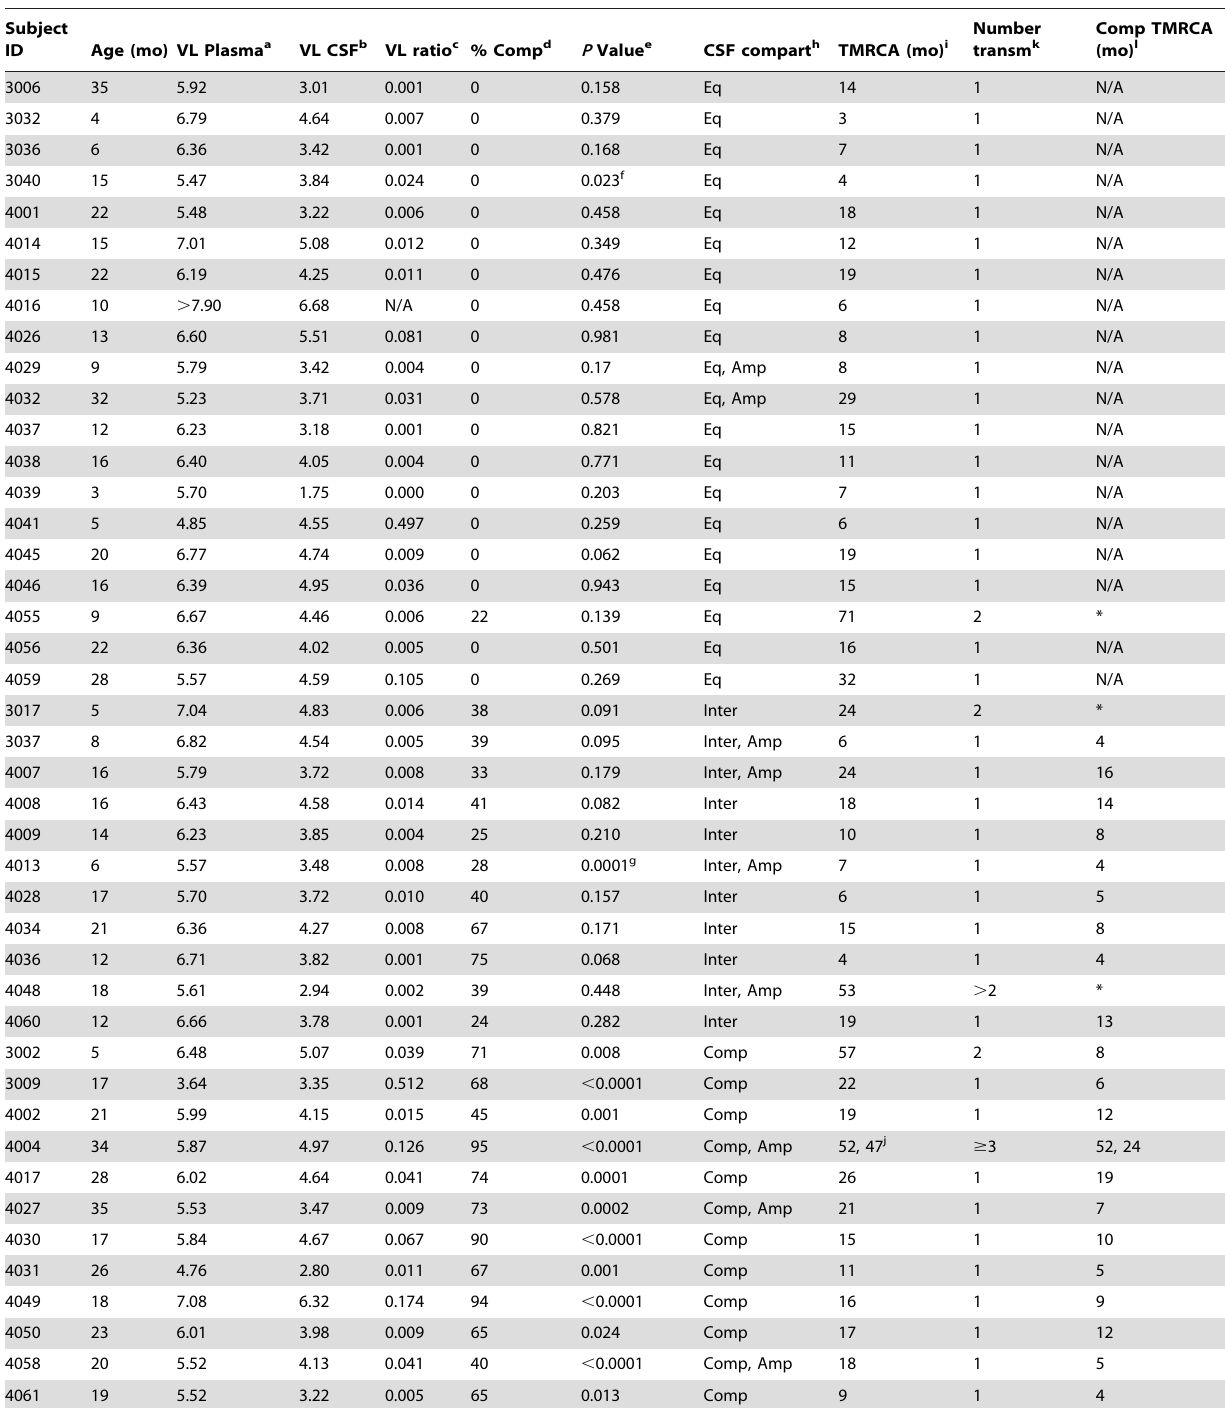
Table 1. Subject population virological and phylogenetic